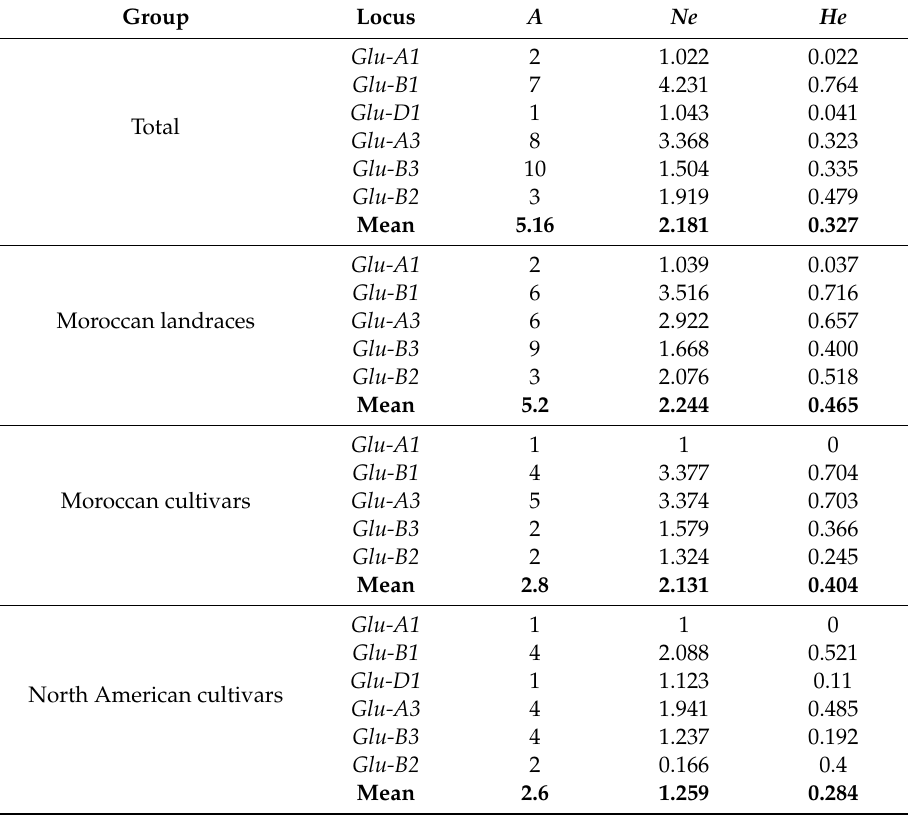
Table 3. Number of alleles and of glutenins patterns, and genetic diversity parameters. Group Locus A Ne He